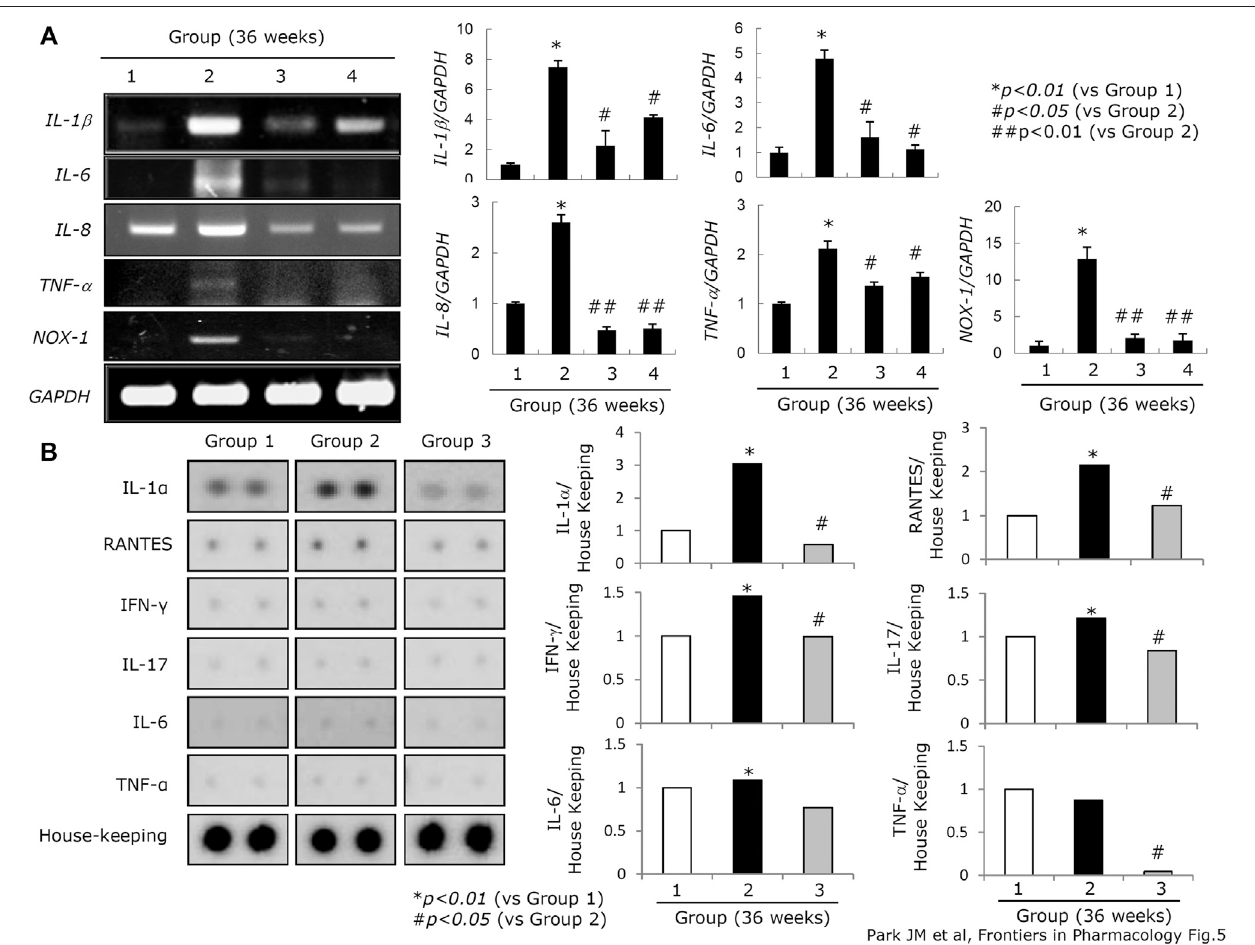
FIGURE 5 | Changes of in fl ammatory mediators according to groups. (A) Left: RT-PCR for IL-1 β , IL-6 , IL-8 , TNF- α , and NOX-1 according to groups; right: mean expressions according to in fl ammatory genes. (B) Left: protein array for in fl ammatory proteins including IL-1 α , RANTES, IFN- γ , IL-17, IL-6, and TNF- α ; right: mean changesofindividualin fl ammatoryproteinsontheproteinarraypanel. (C) Westernblotforp-NF- κ Bp65andp-STAT3. (D) ImmunohistochemicalstainingforNF- κ Bp65 accordingtogroups. (E) ImmunohistochemicalstainingforF4/80denoting thestatusofmacrophagesaccordingtogroups, x100magni fi cation.All datarepresent mean ± SD ( n (cid:1)